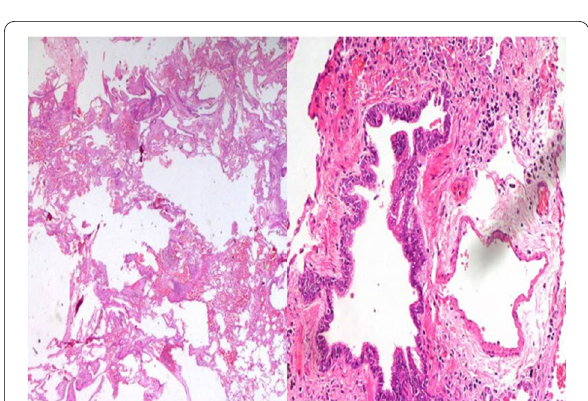
Fig. 5 Multiple sections identified from the cystic area in the lung on hematoxylin and eosin stain show presence of multiple variable sized cystically dilated spaces lined by bronchial epithelium. Along with it, many dilated ectatic alveolar spaces area seen